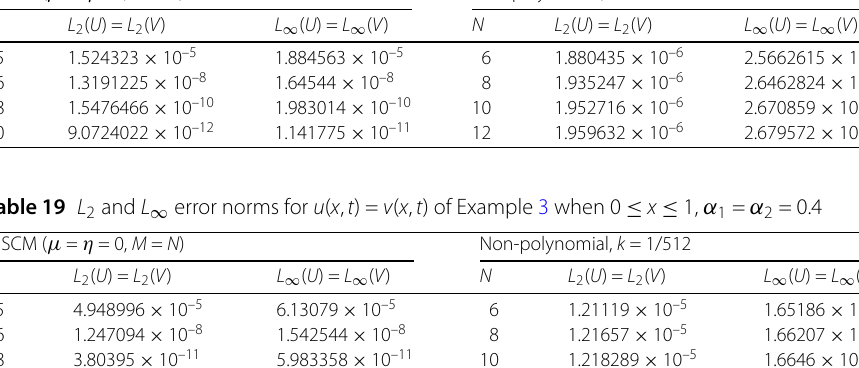
Table 18 L 2 and L ∞ error norms for u ( x , t ) = v ( x , t ) of Example 3 when 0 ≤ x ≤ 1, α 1 = α 2 = 0.2 SJSCM ( μ = η = 0, M = N ) Non-polynomial, k = 1/512